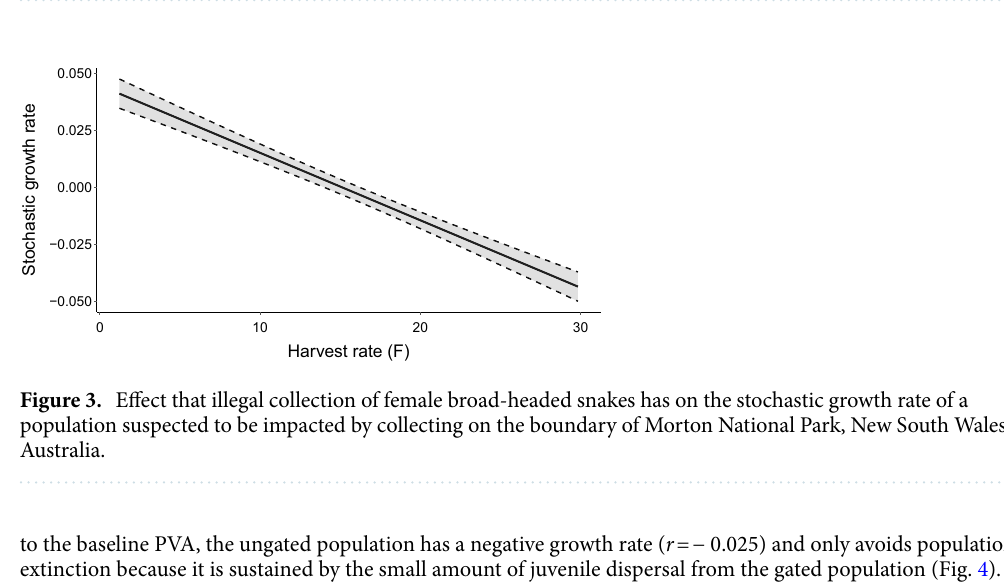
Figure 2. Effects that five vital rate parameters have on the stochastic population growth rate of broad- headed snakes in an ungated population suspected to be subjected to illegal collecting on the boundary of 29 Morton Nation Park, New South Wales, Australia. Parameter values have been scaled and centred to allow for comparison. Grey shading represents 95% confidence intervals.